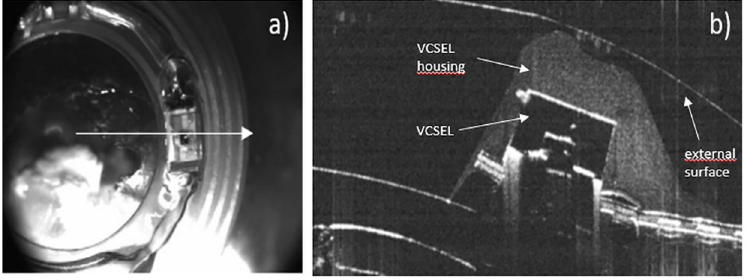
Fig 11. New manufacturing design to control the VCSEL eccentricity. a) top view CLP of the CLP, the arrow illustrates the meridian of the cross section depicted in b); b) cross-section showing the VCSE in its housing.